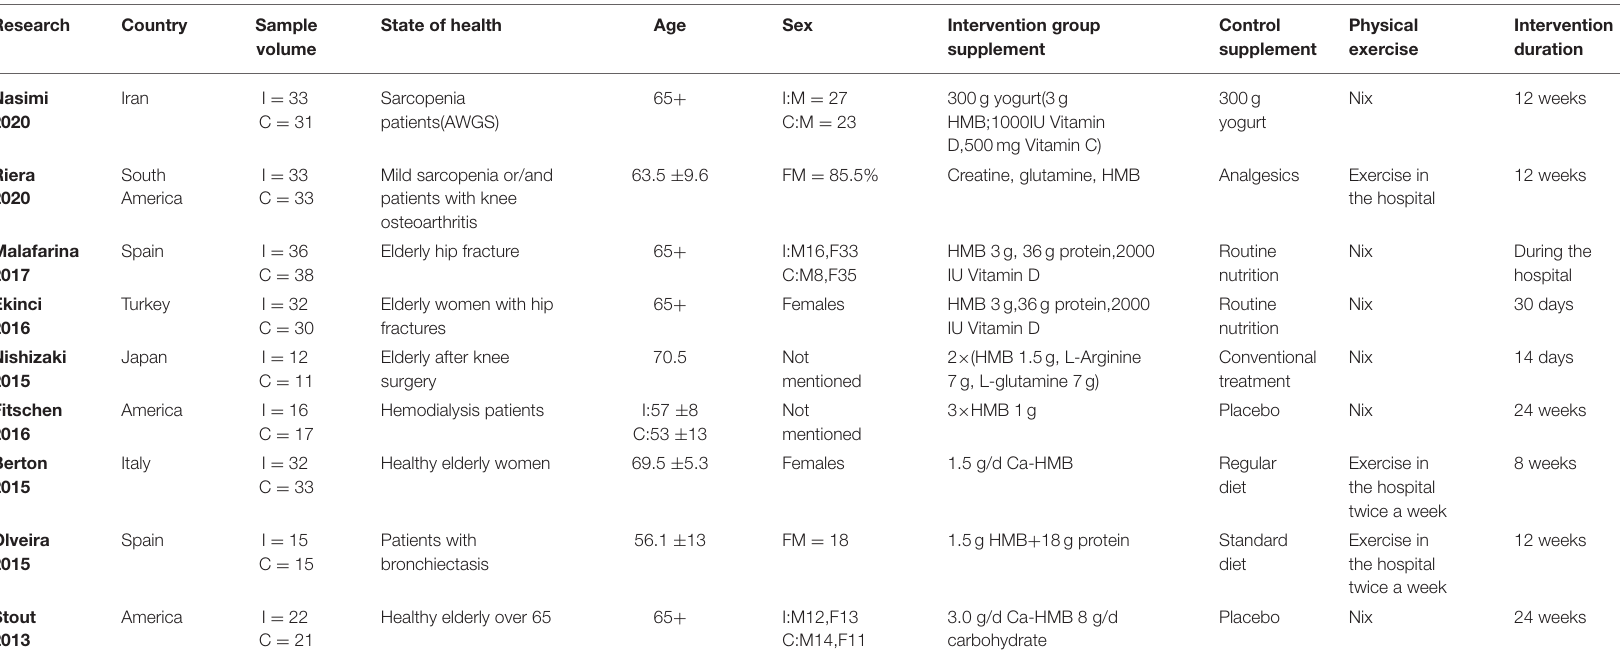
TABLE 2 | Characteristics of include